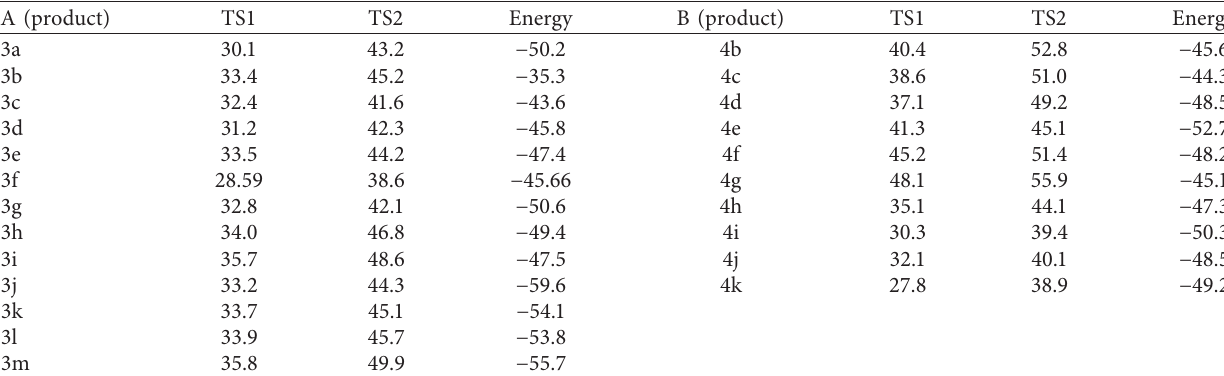
Table 1: Energy of transition states TS1 and TS2 for all compounds